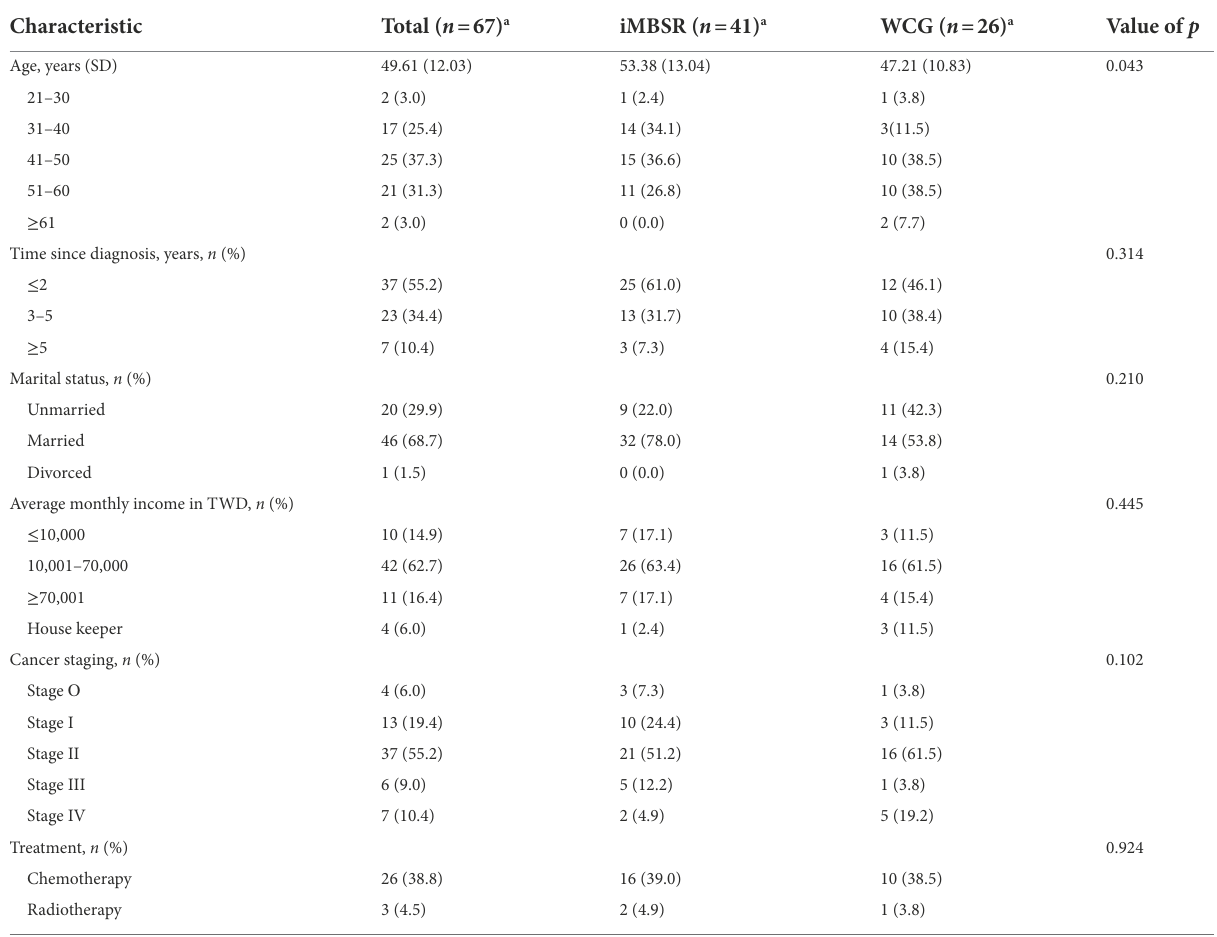
TABLE 3 The demographic and clinical characteristic of patients with breast